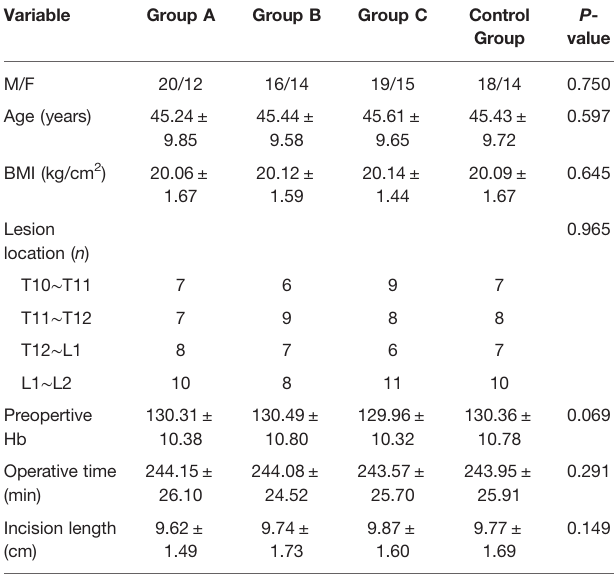
TABLE 1 | Baseline parameters of patients in the 4